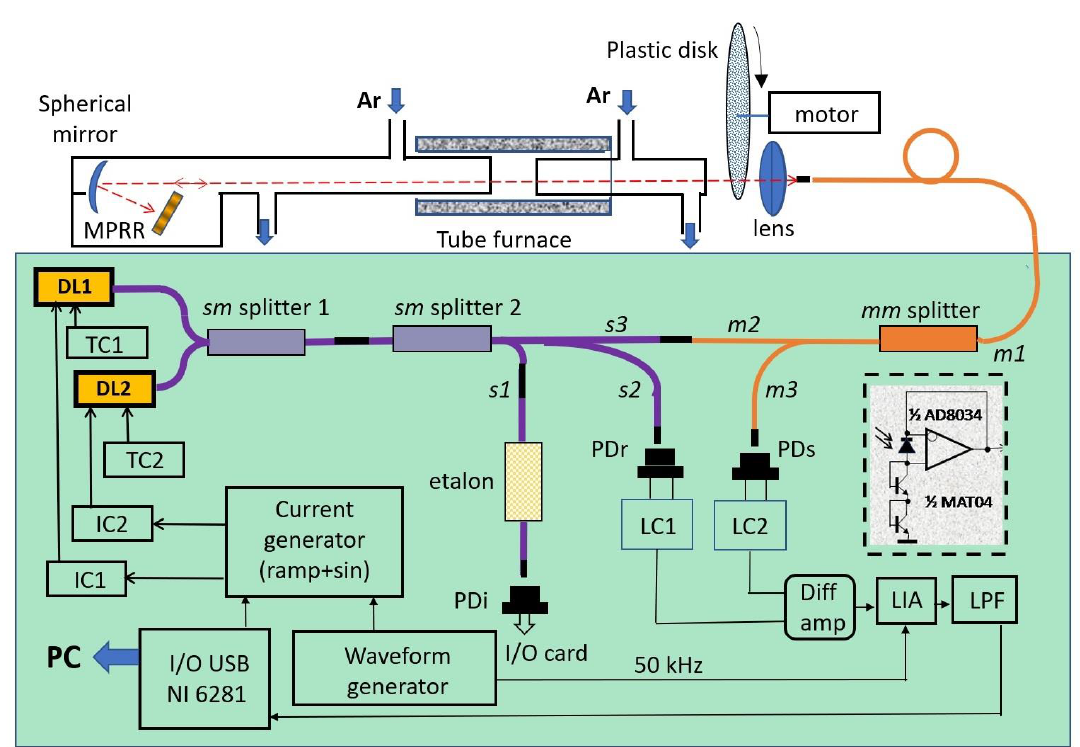
Figure 1. Experimental set-up. MPRR—micro-prism retroreflector; DL1, DL2—diode lasers; TC, IC—temperature and current controllers, respectively; sm —single mode, mm —multimode; s1 , s2 , s3 —single-mode fibers; m1 , m2 , m3 —multimode fibers; PDr, PDs, PDi—photodiodes of the reference, sample, and interferometric channels, respectively; LC1, LC2—logarithmic converters of the reference and sample channels, respectively; Diff amp—differential amplifier; LIA—lock-in amplifier; LPF—low-pass filter; PC—personal computer. The electrical scheme of the LC is shown in the insert.